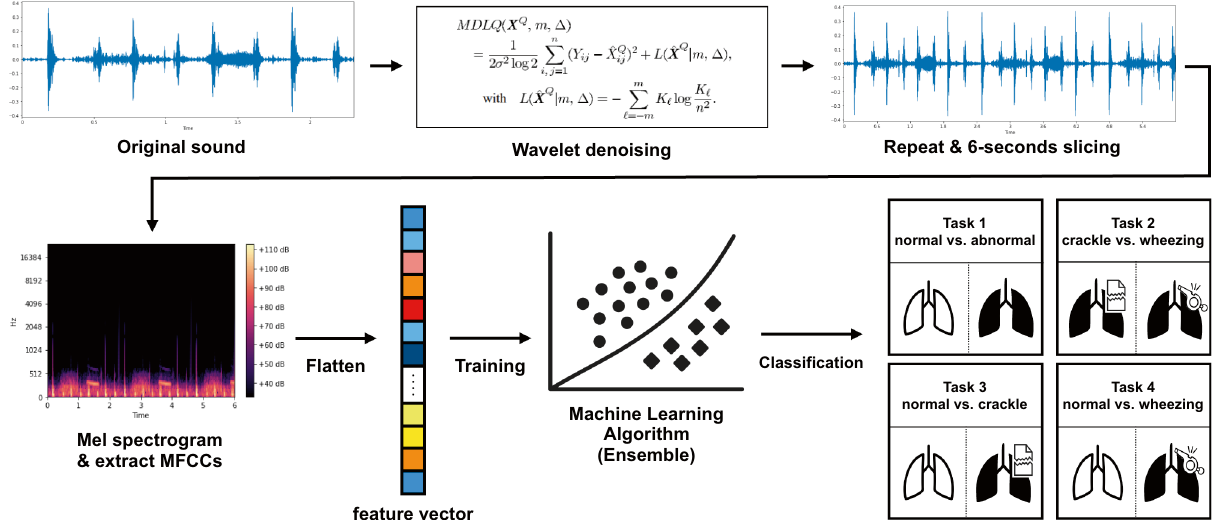
Figure 4. Data preprocessing and machine learning algorithm framework. The original sound clip underwent wavelet denoising, and was duplicated and cropped into 6-s windows. MFCCs extracted from the mel- spectrograms were used to train the ensemble models of the support vector machines. Four classification tasks were used for training: (1) normal vs. abnormal, (2) crackles vs. wheezing, (3) normal vs. crackles, and (4) normal vs. wheezing. MFCC, mel-frequency cepstral